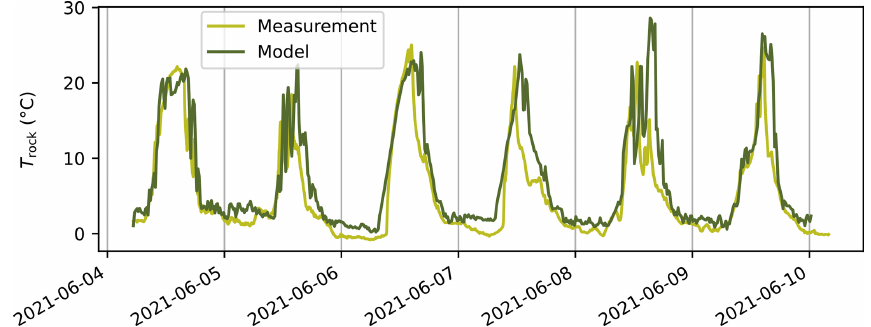
Figure 6. Temperature T rock of the top surface of rock 4 measured using a thermocouple (light green) and predicted by the model using the meteorological data of period B (dark line). The date format is